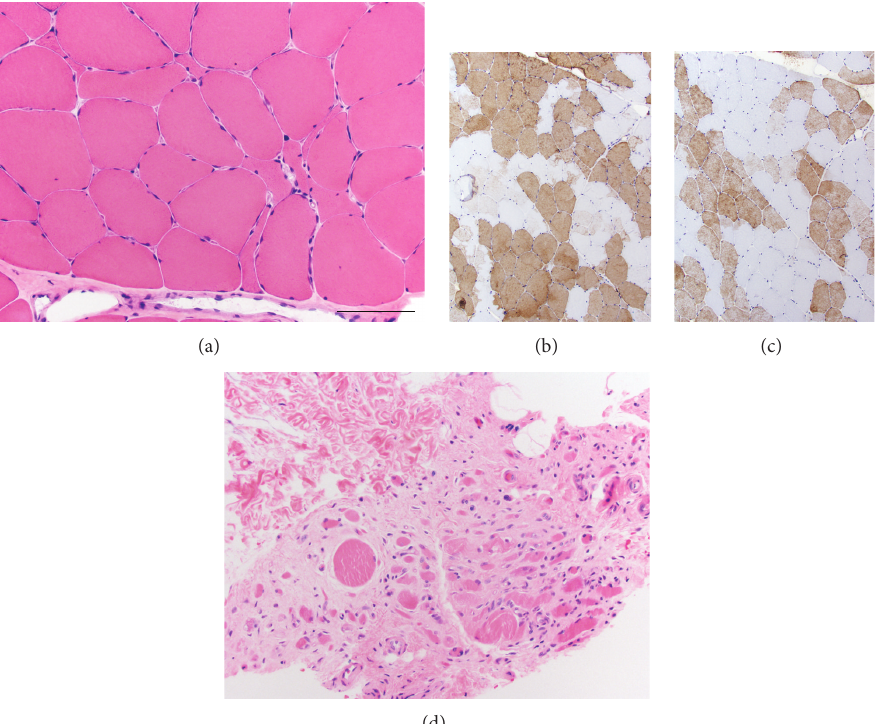
Figure 2: Muscle biopsy of the quadriceps revealed chronic active neurogenic atrophy ((a), H&E). Fiber type grouping is seen in immunoperoxidase staining for both slow myosin (b) and fast myosin (c). Some muscle fascicles are much more severely affected and show features of end stage muscle (d). Scale bar = 100 𝜇 m in panels (a) and (d); 150 𝜇 m in panels (b) and